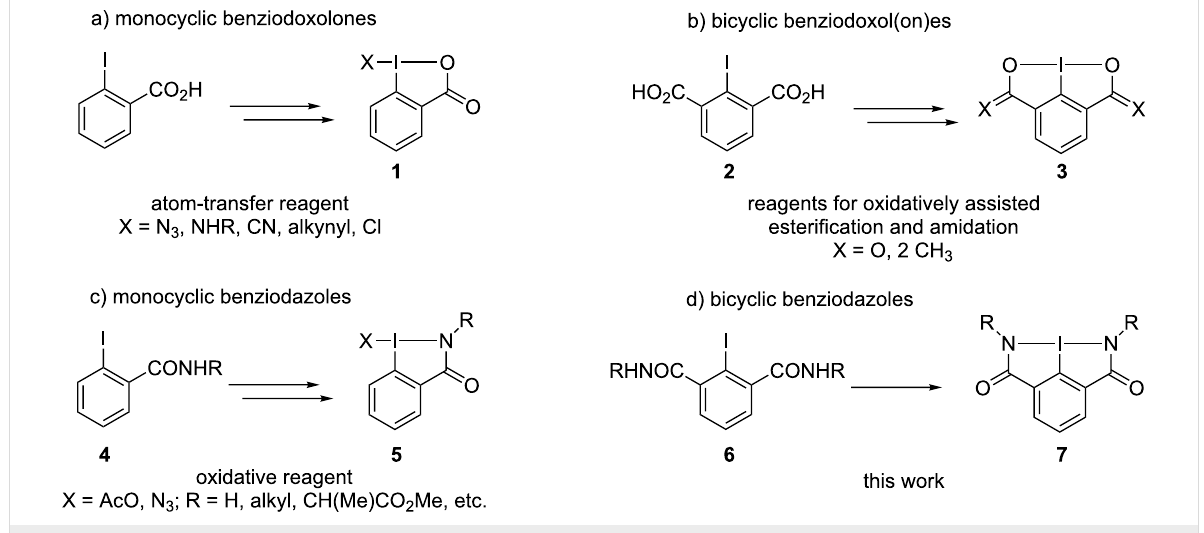
Scheme 1: Representative examples of benziodoxoles and benziodazoles.